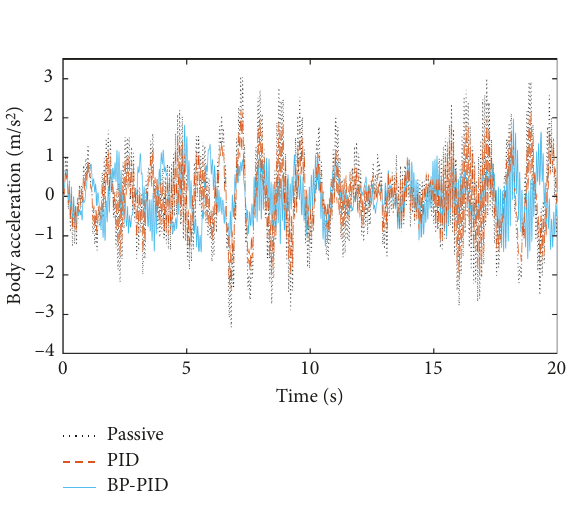
Figure 8: Body acceleration.